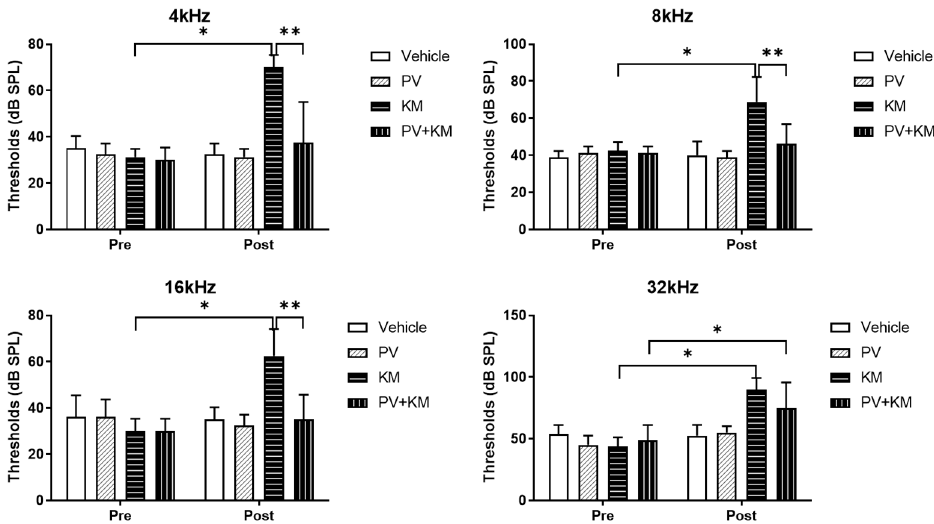
Figure 1. The auditory brainstem response (ABR) thresholds at 4, 8, 16, and 32 kHz of each group were measured using smartEP system. The KM-treated rats demonstrated increased hearing thresholds at 4, 8, 16, and 32 kHz after KM administration, compared with those before drug administration. The PV + KM-treated rats showed lower hearing thresholds at 4, 8, and 16 kHz than the KM-treated rats. (* p < 0.05, paired t -test between pre- and post-drug treatment; ** p < 0.005, unpaired t -test between